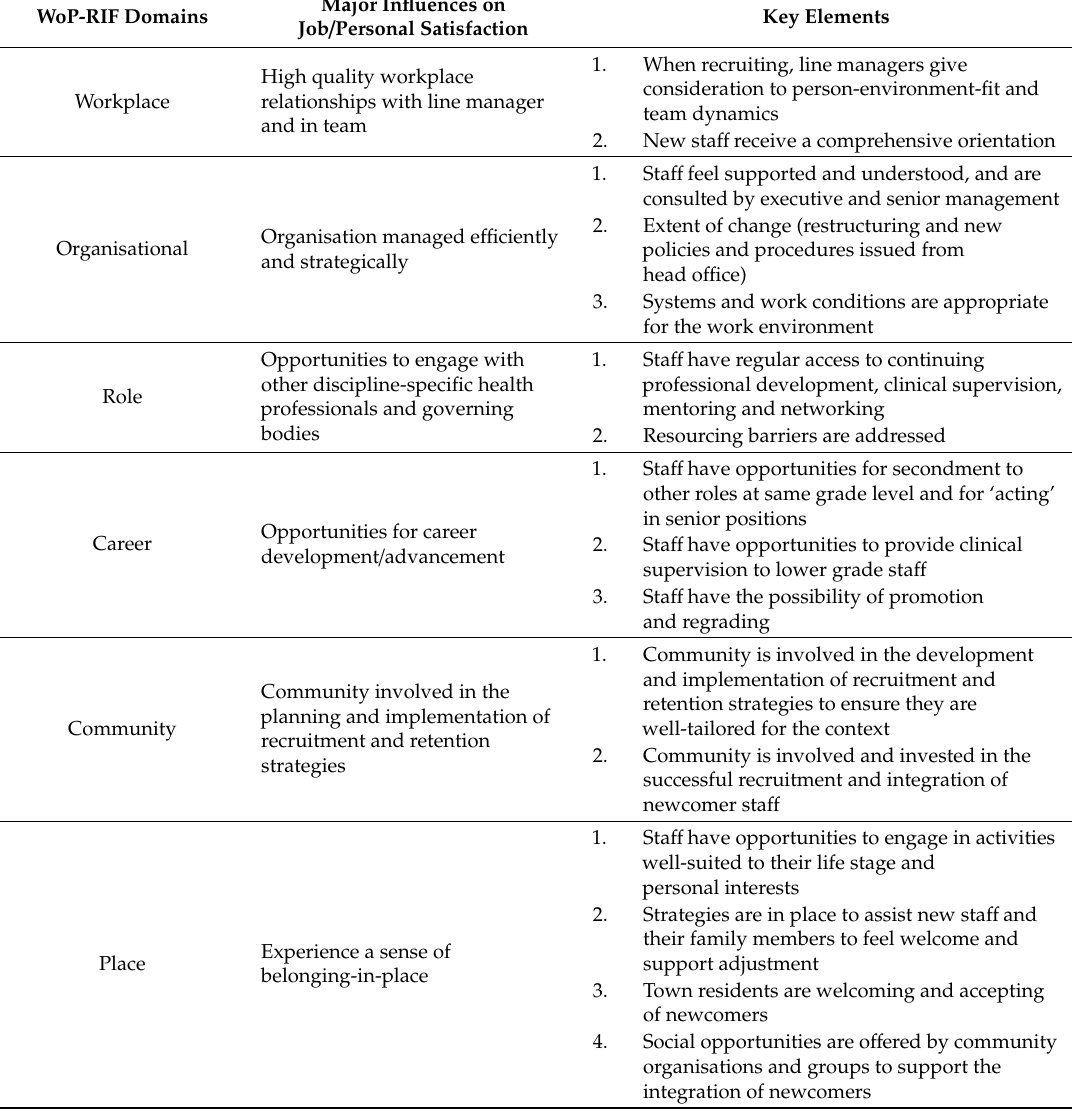
Table 1. Influences and key elements on job / personal satisfaction drawn from the rural health workforce literature—categorised under the relevant Whole-of-Person Retention Improvement Framework (WoP-RIF)